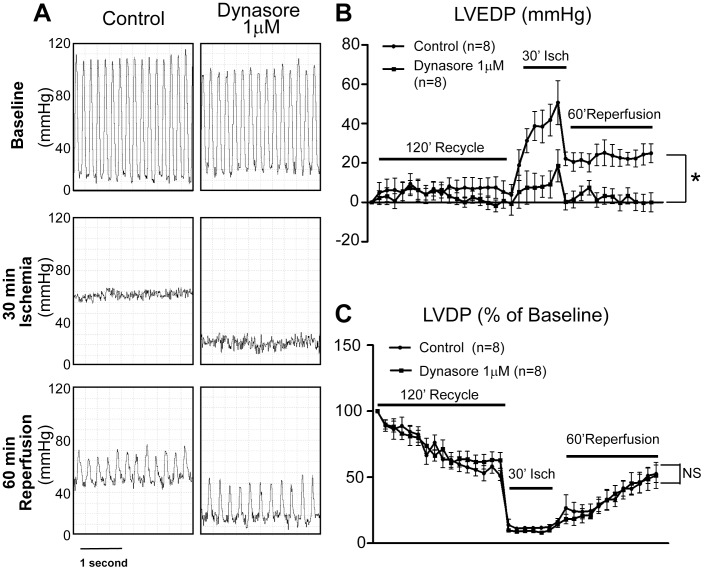
The cardiac lusitropic effect of Dynasore.Effect of 1 µM Dynasore pretreatment on ventricular function was studied in Langendorff perfused mouse hearts subjected to 30 min no-flow global ischemia followed by 60 min reperfusion. Hearts were paced at 360 bpm during the whole experimental protocol except the ischemia period and pacing was reinitiated at 2 min into the reperfusion period. A. Representative Left ventricular pressure tracing in a control heart and a Dynasore treated heart. B, C; Left ventricular end diastolic pressure (LVEDP, B) and left ventricular developed pressure (LVDP, C) are summarized and compared between control group and Dynasore group. (* P<0.05).